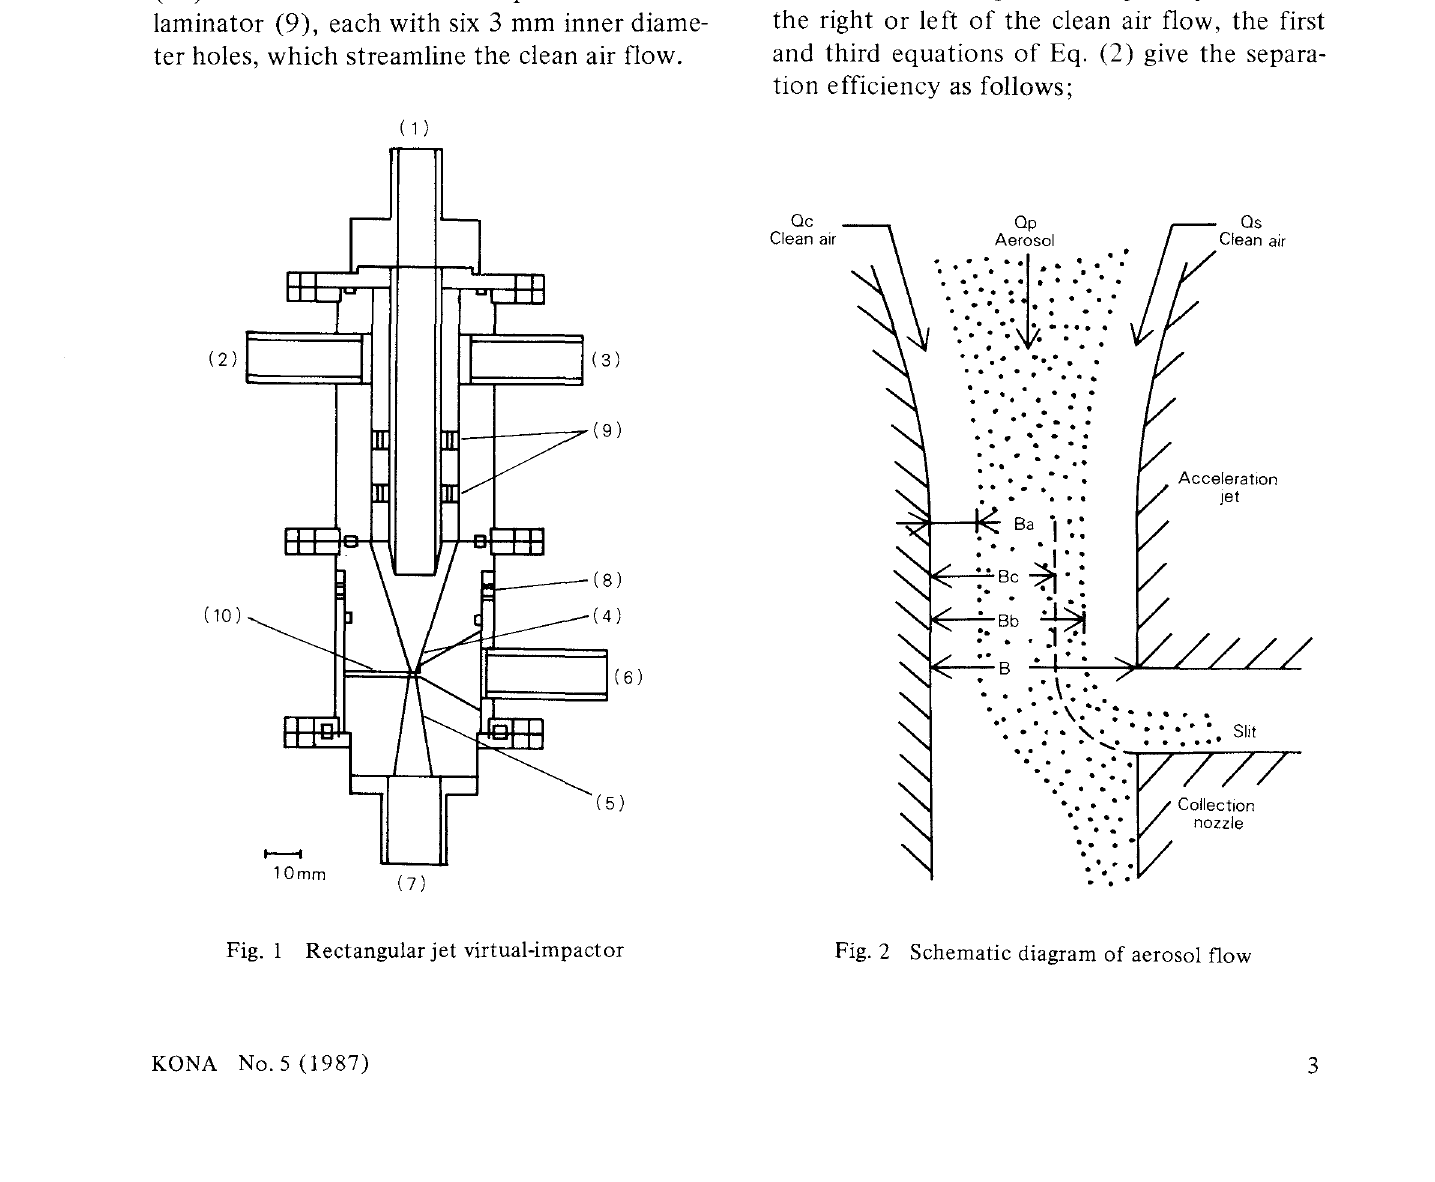
Fig. 1 Rectangular jet virtual-impactor Fig. 2 Schematic diagram of aerosol flow